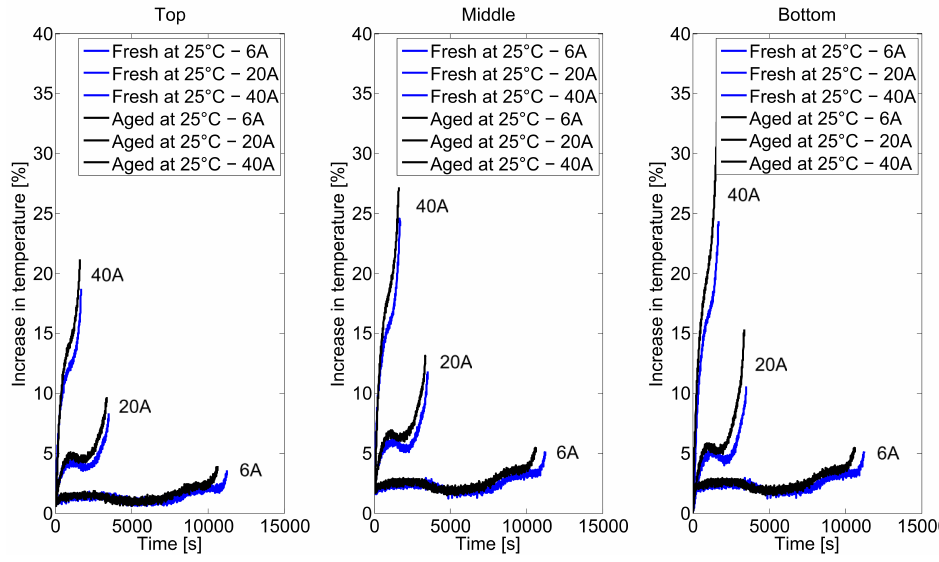
Figure 14. Temperature increase at 25 ◦ C for fresh and aged